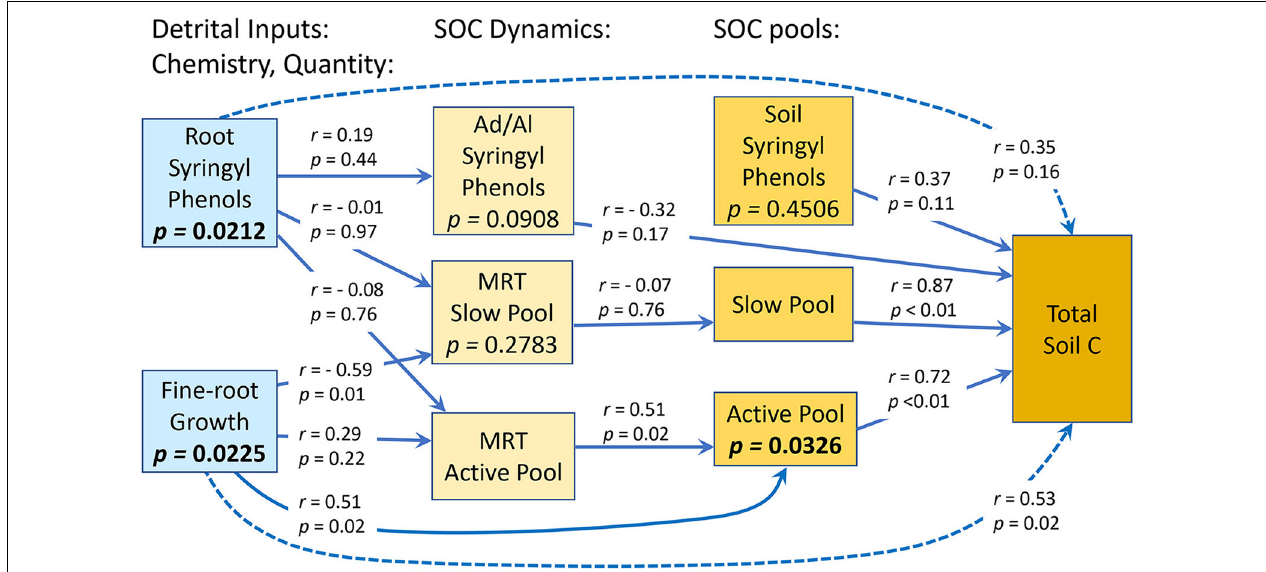
FIGURE 1 | Relationships between quantity and chemistry of detrital inputs to soil, and SOC dynamics and pools in an experiment containing five tropical tree species. Results of correlations are shown on arrows connecting the pair of variables in the analysis. P- values in boxes are from partial residual analyses. N = 20 plots.